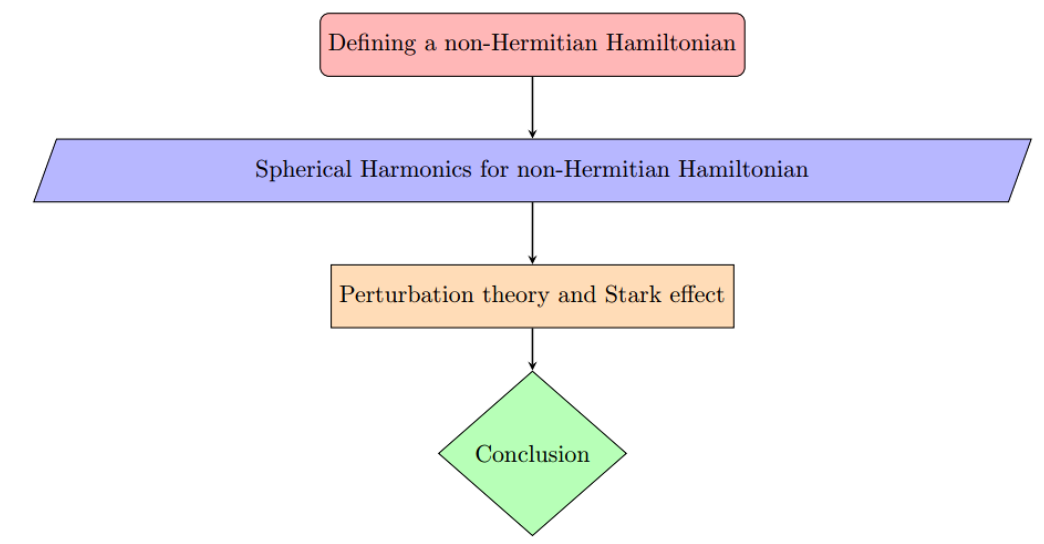
Figure 1. Flowchart of the research